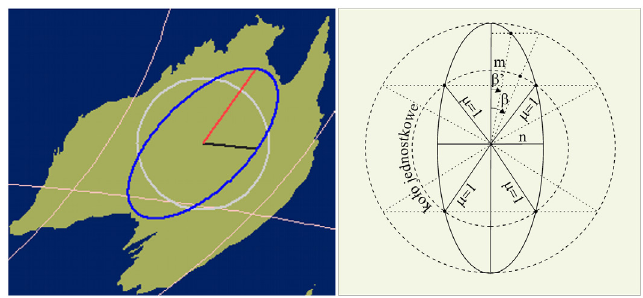
Fig. 4. The presentation of the local distortions using the Tissot’s indicatrix in the neighborhood of a point (source: http://www.uni-stuttgart.de/gi/geoengine/mappro/ and P. Pędzich 2014)